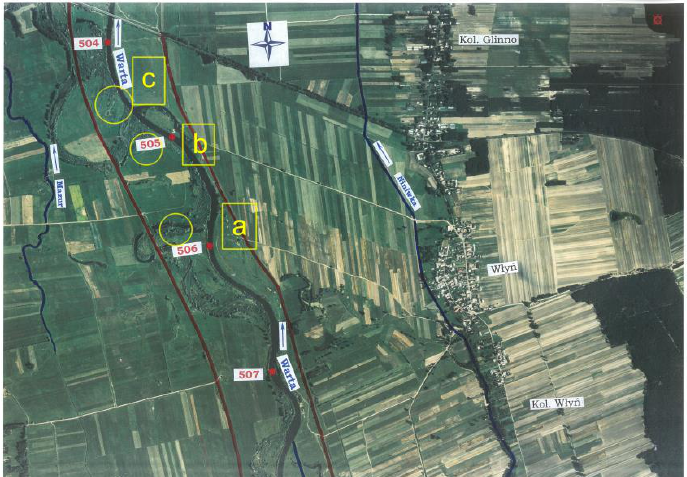
Figure 2. Case study system-reach of Warta River.